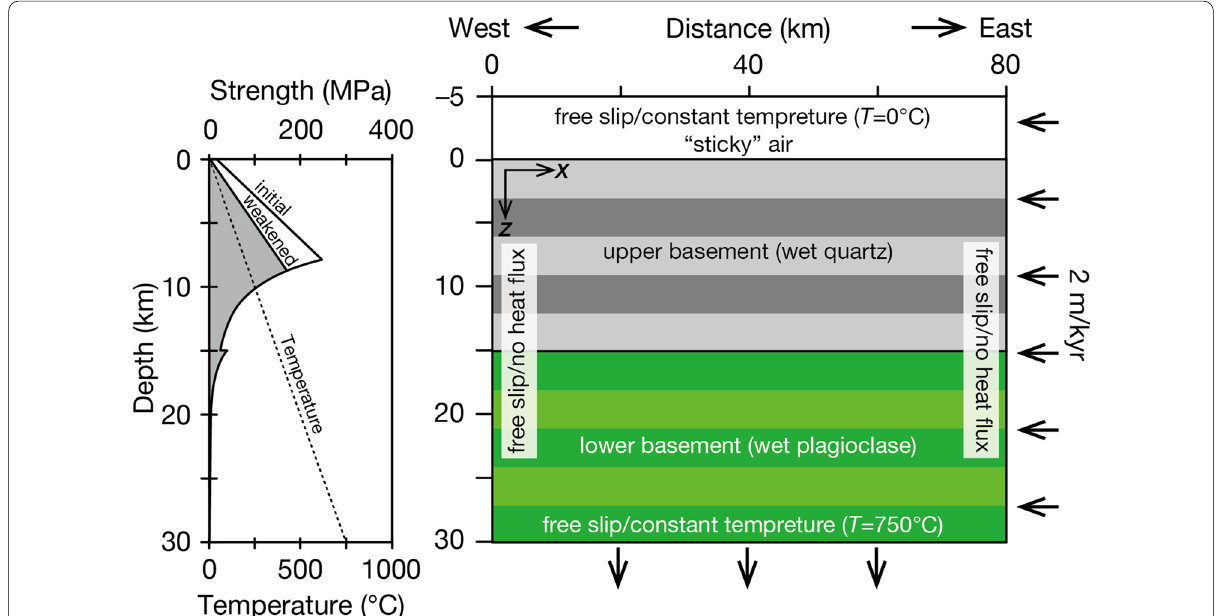
Fig. 6 Model geometry and boundary conditions. A constant horizontal velocity (2 m/kyr) and a changing downward velocity (from 0.88 m/kyr at 0 Myr to 1.02 m/kyr at 3 Myr) are applied at the right and bottom boundaries, respectively. The inset shows the crustal strength profile (solid lines and curves), with the strain rate ( ˙ ε ) of 5 10 − 16 /s, the initial friction coefficient ( μ i ) of 0.7 and the weakened friction coefficient ( μ w ) of 0.5, and × temperature profile (dashed line) at the initial state in the numerical